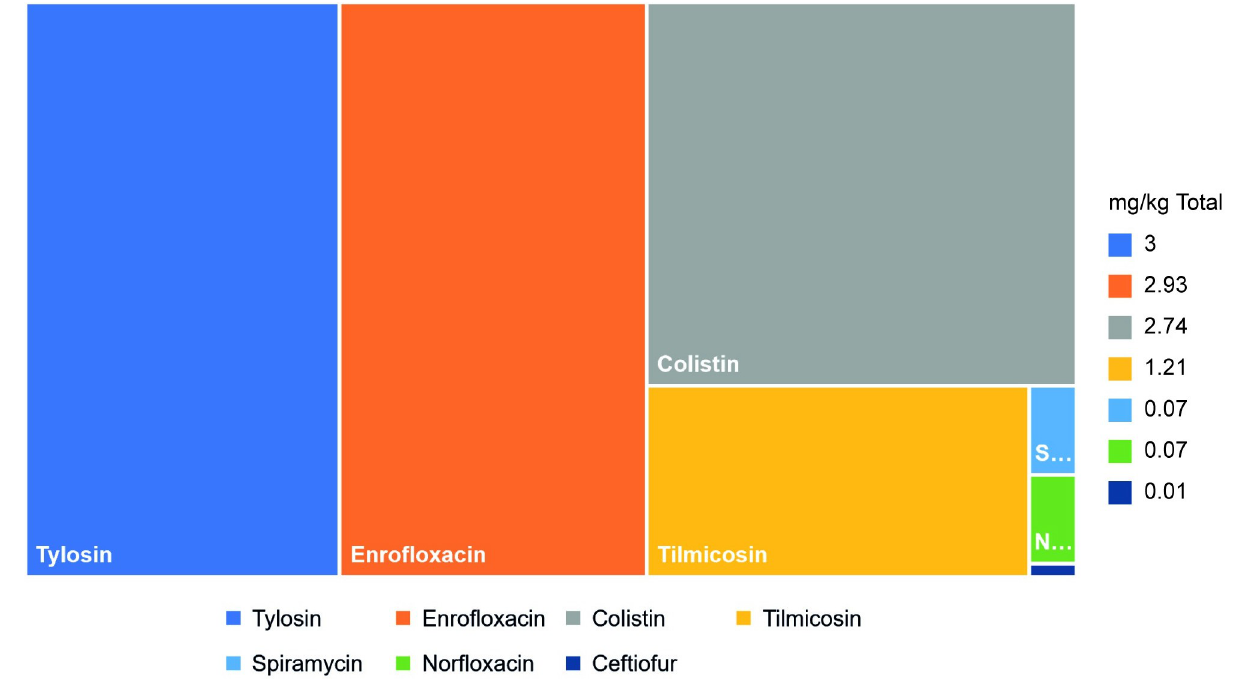
Fig 5. Total import volumes of pharmaceutical raw materials adjusted for total animal biomass for the years